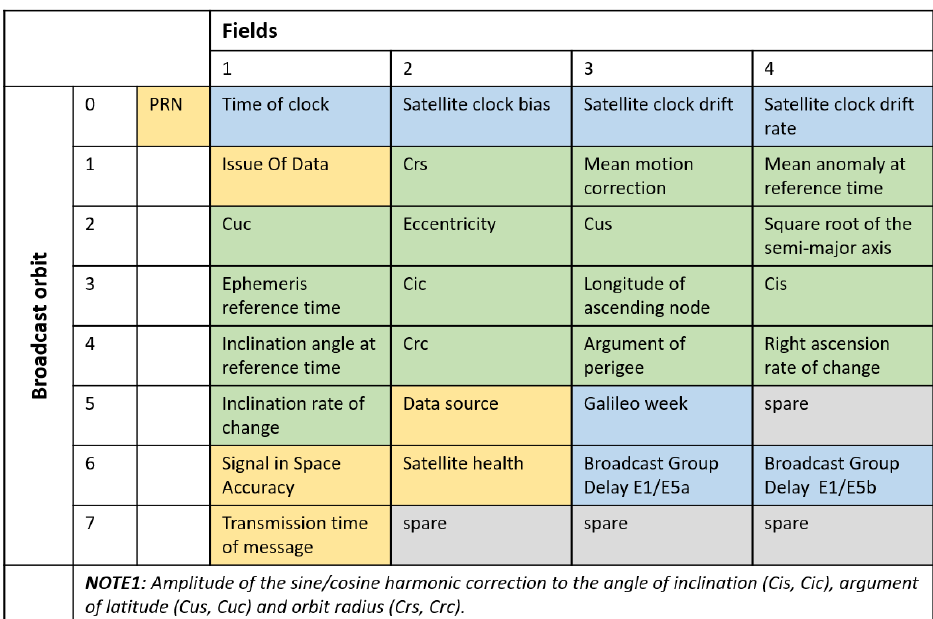
Figure 2. Parameters retrieved from a Galileo navigation data record as found in the BRDC00IGS product provided in the RINEX version 3 format [32]. Please notice that some parameters are navigation message specific. Thus, the numerical values are different between F/NAV and I/NAV navigation message.